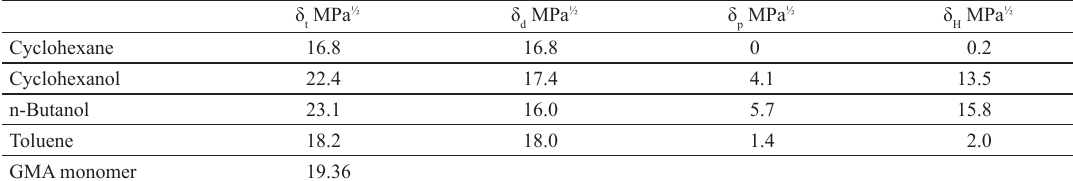
Table 2. Solubility Parameters to solvents employed as diluents on polymerization of the monomers GMA and EDGMA 20